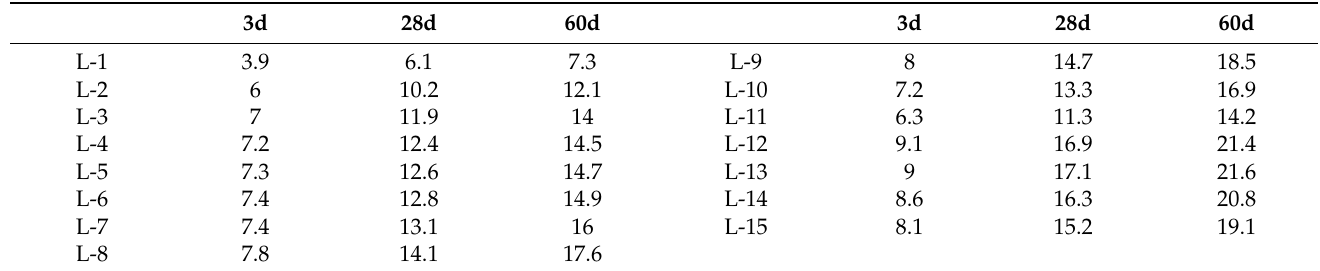
Table 3. Compressive Strength Analysis Results